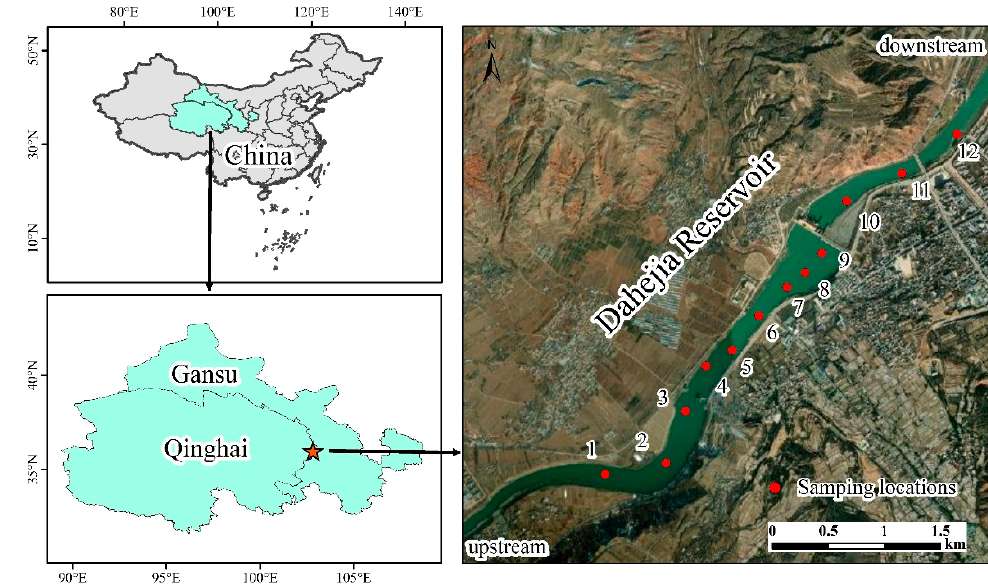
Figure 1. Location map of the study site. Twelve sampling points were subdivided into four subregions: River (1–3), Middle (4–6), Lake (7–9), and Down (10–12).